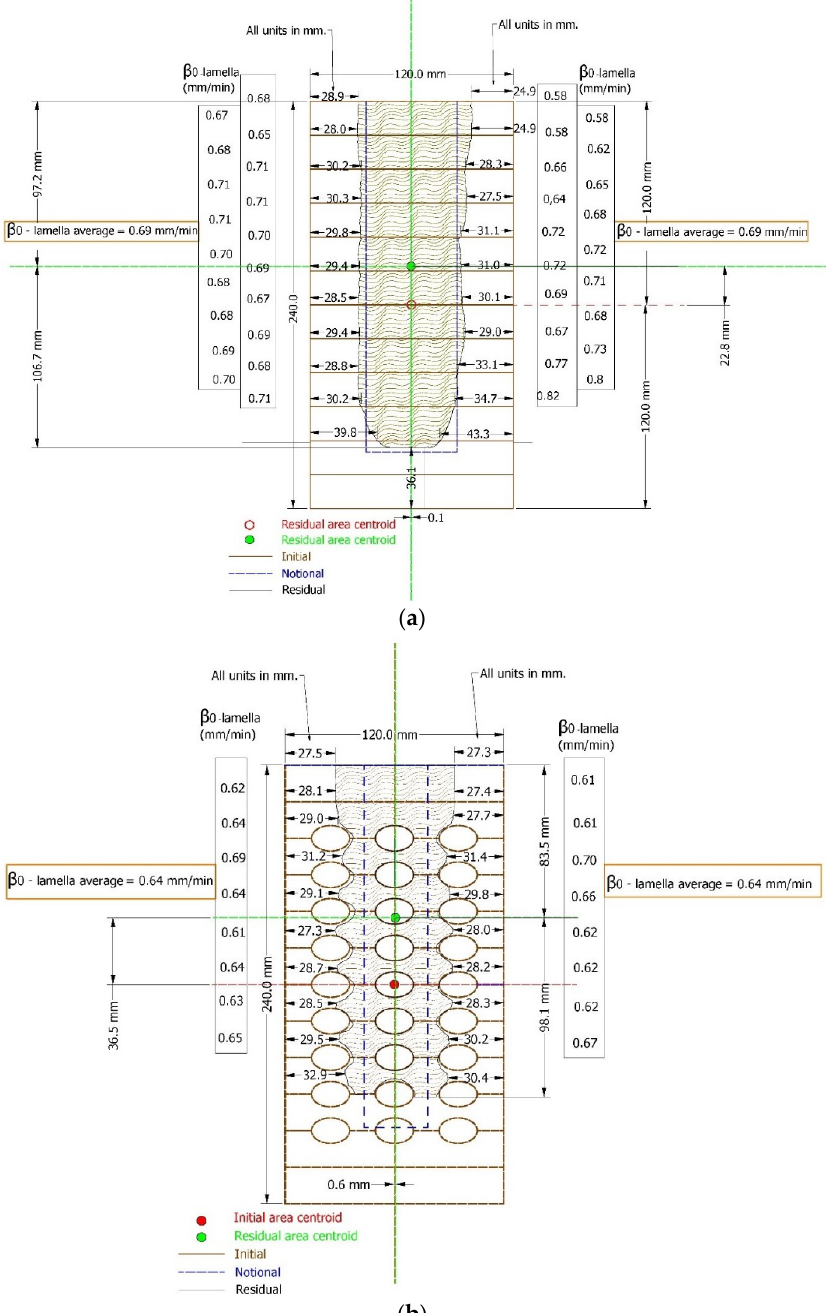
Figure 22. Residual cross-section analyzed with CAD software, dimensions in (mm): ( a ) normal GL beam; ( b ) hollow GL beam protected by intumescent paint.